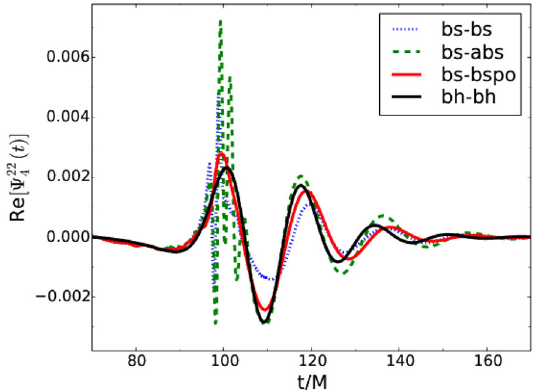
Fig. 33 Gravitational waves, represented by the l ¼ m ¼ 2 mode of the Newman-Penrose scalar, W 4 , emitted during the head-on collision of two solitonic BSs. For all con fi gurations, the fi nal object is massive enough to promptly collapse to a BH. However, for the boson – boson and boson – anti-boson con fi gurations the late inspiral signatures differ signi fi cantly from the corresponding binary black-hole signal. Reproduced with permission from Cardoso et al. (2016), copyright by the